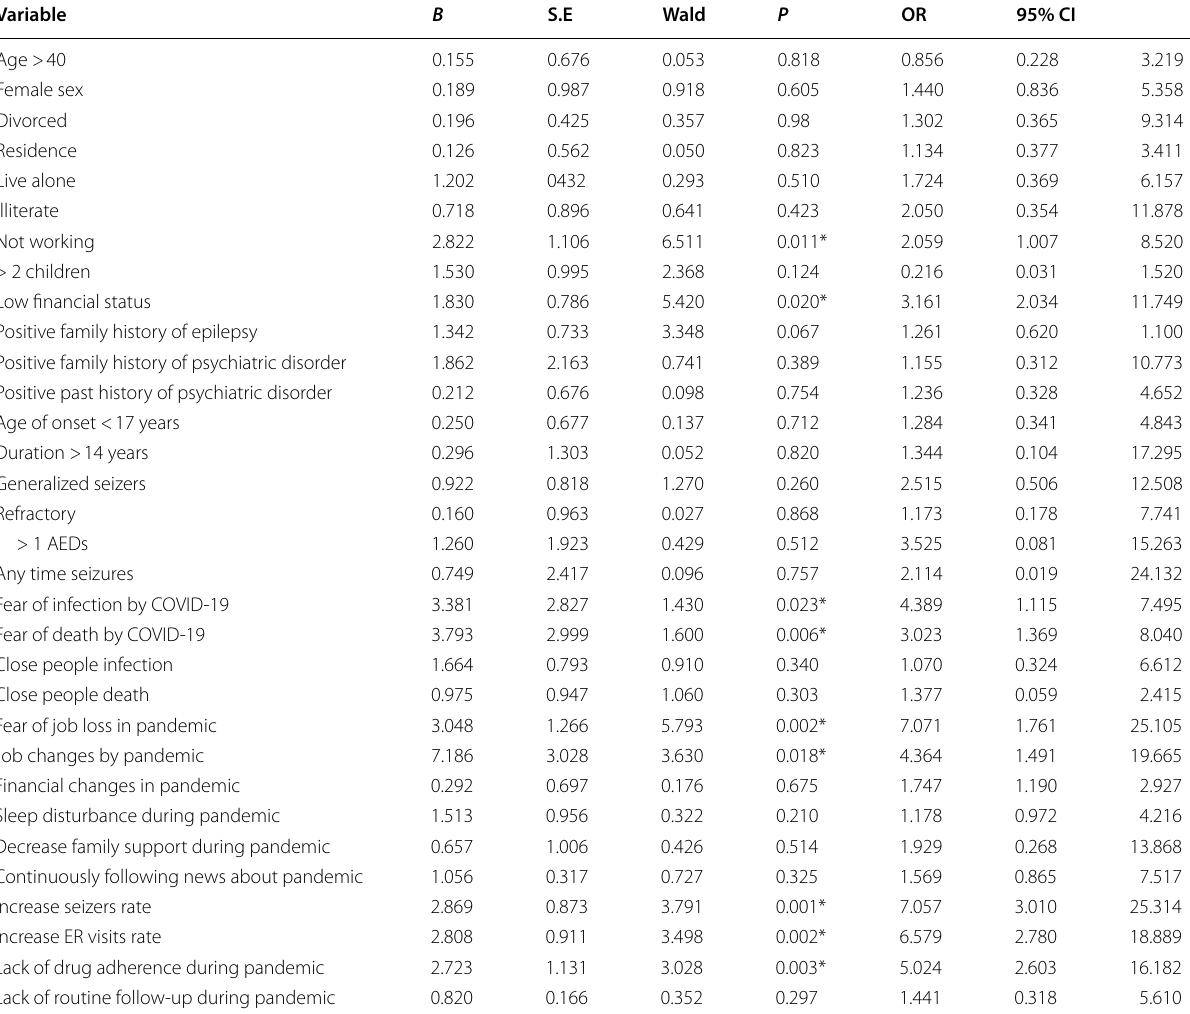
SE standard error, OR odds ratio, CI confidence interval. *Significant ( P < 0.05) **highly significant ( P <